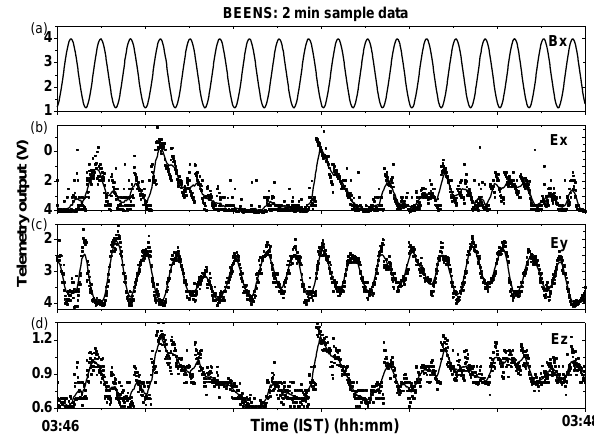
Figure 11. The raw outputs from the x , y and z probe pairs (b–d) along with the magnetometer x channel output (a)